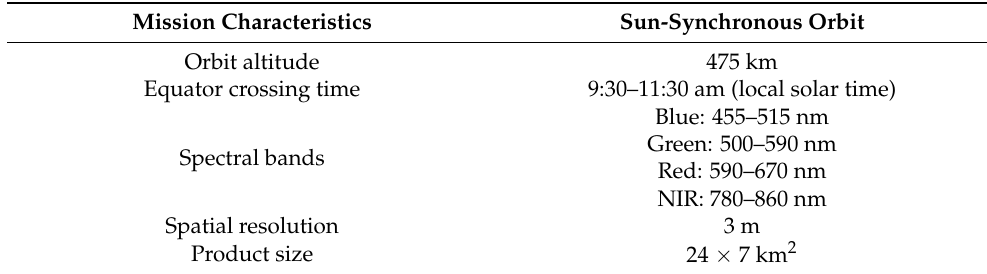
Table 1. Constellation overview of PlanetScope.